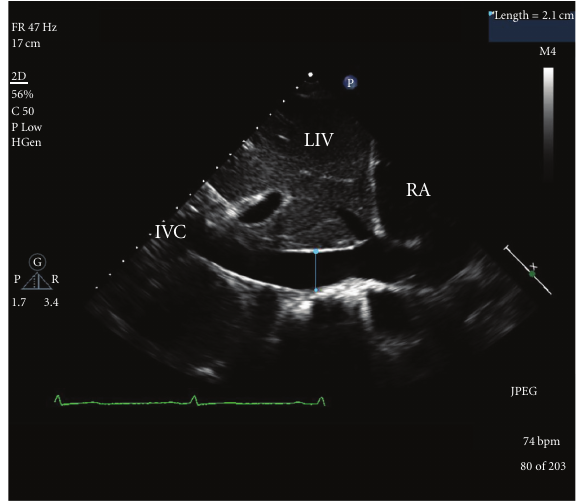
Figure 3: A subcostal view of the cavoatrial junction and adjacent structures. RA: right atrium; IVC: inferior vena cava; LIV: liver.